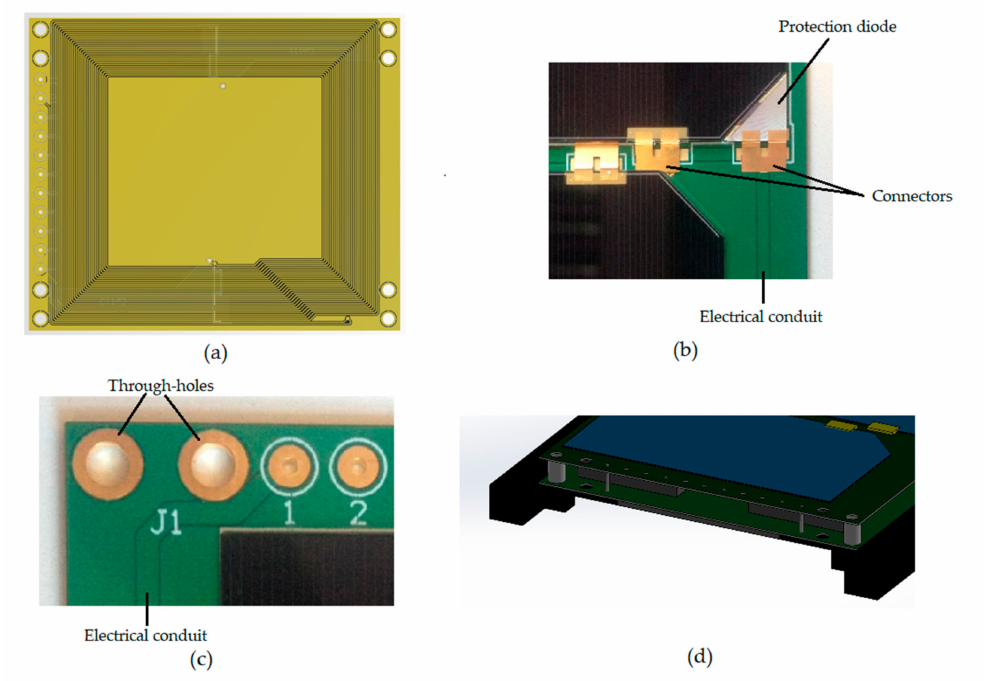
Figure 4. Power management tile electronic details: magnetorquer ( a ), solar cells connectors with protection diode ( b ), solar cells electrical conduit ( c ), and electrical connection with battery array ( d